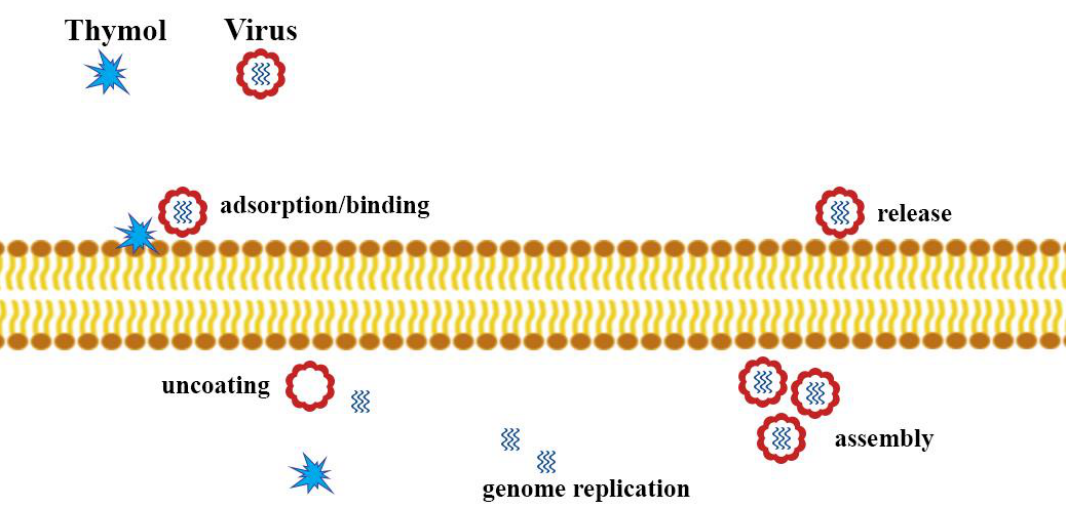
Figure 6. Possible mechanism of antiviral activity of